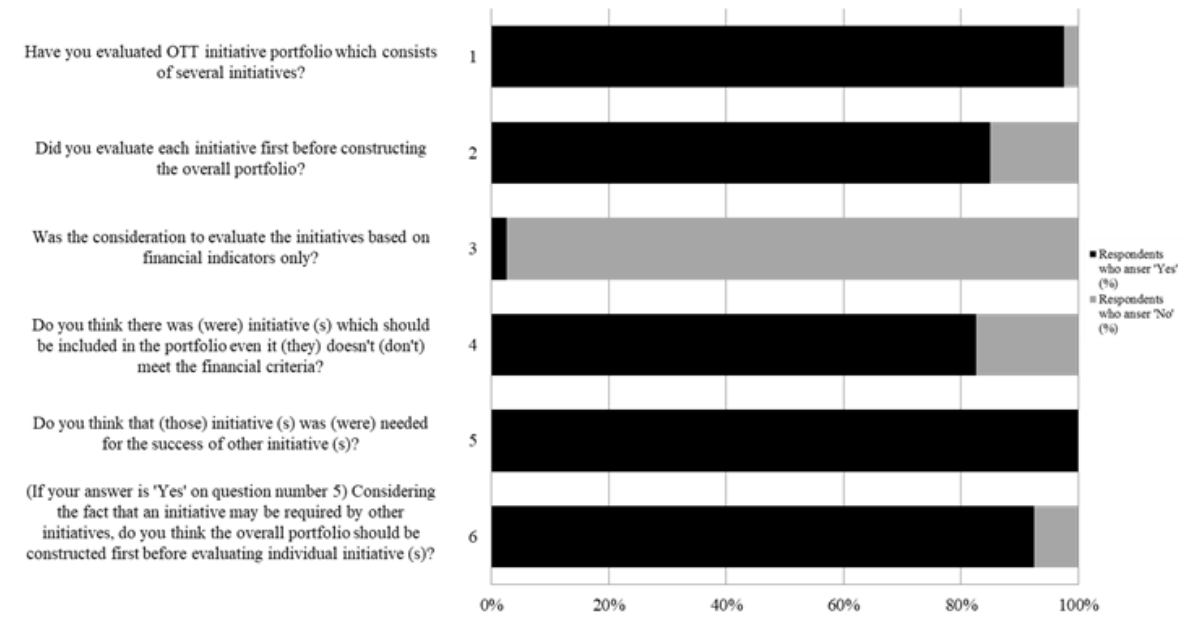
Figure 2. Questionnaire Results on Portfolio Selection Process for OTT